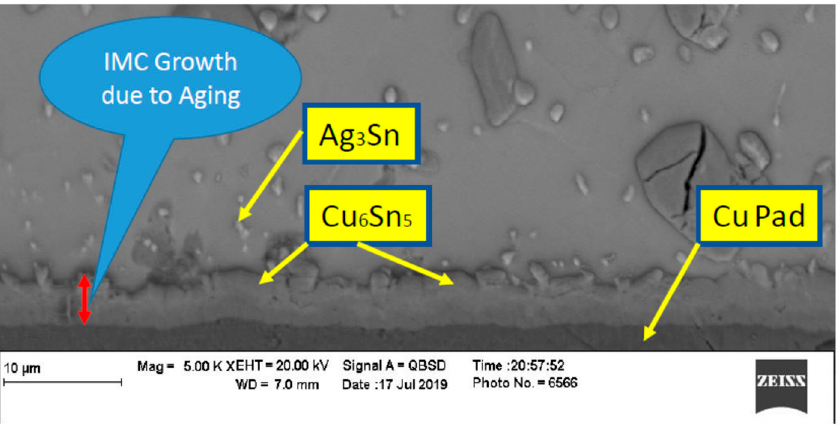
Figure 8. Microstructure of SAC305 thermally aged at 150 °C for 1000 h.